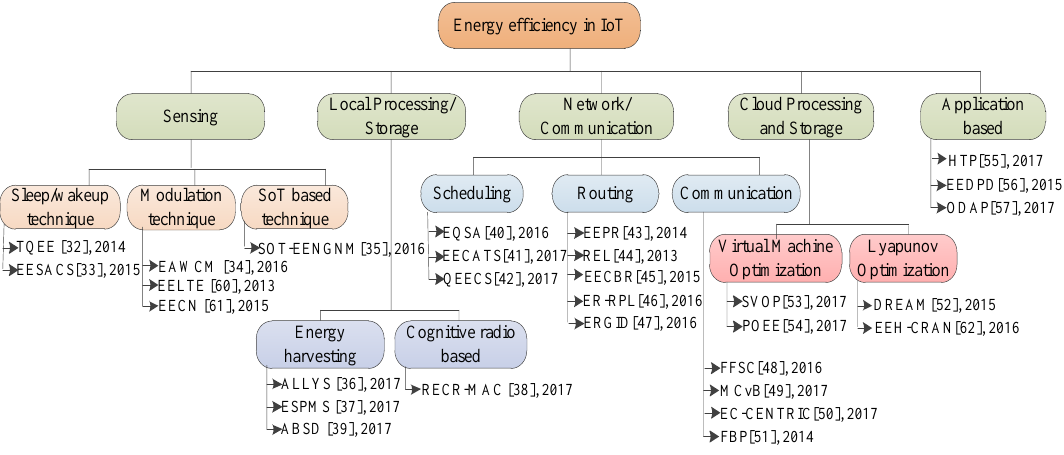
Figure 7. Taxonomy of energy efficient techniques in IoT.